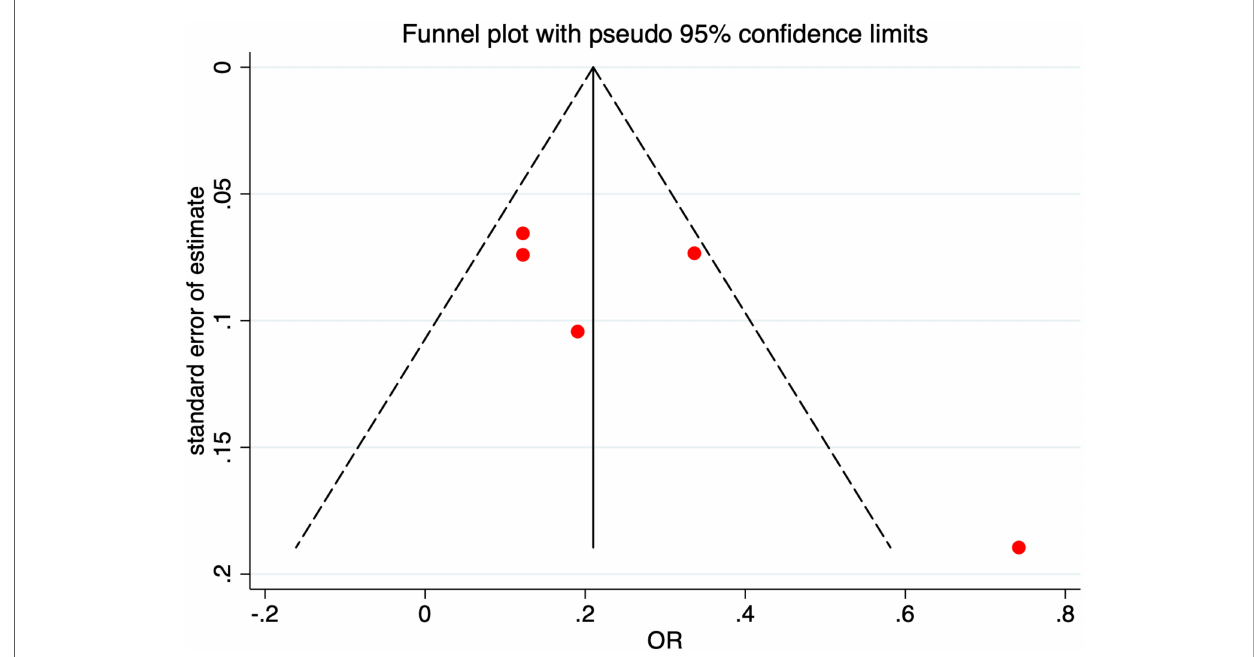
FIGURE 2 Funnel plot for odds ratio. Funnel plot assessing the possibility of publication bias with pseudo 95% con fi dence intervals. Abbreviations: SE, standard error; OR, odds ratio.